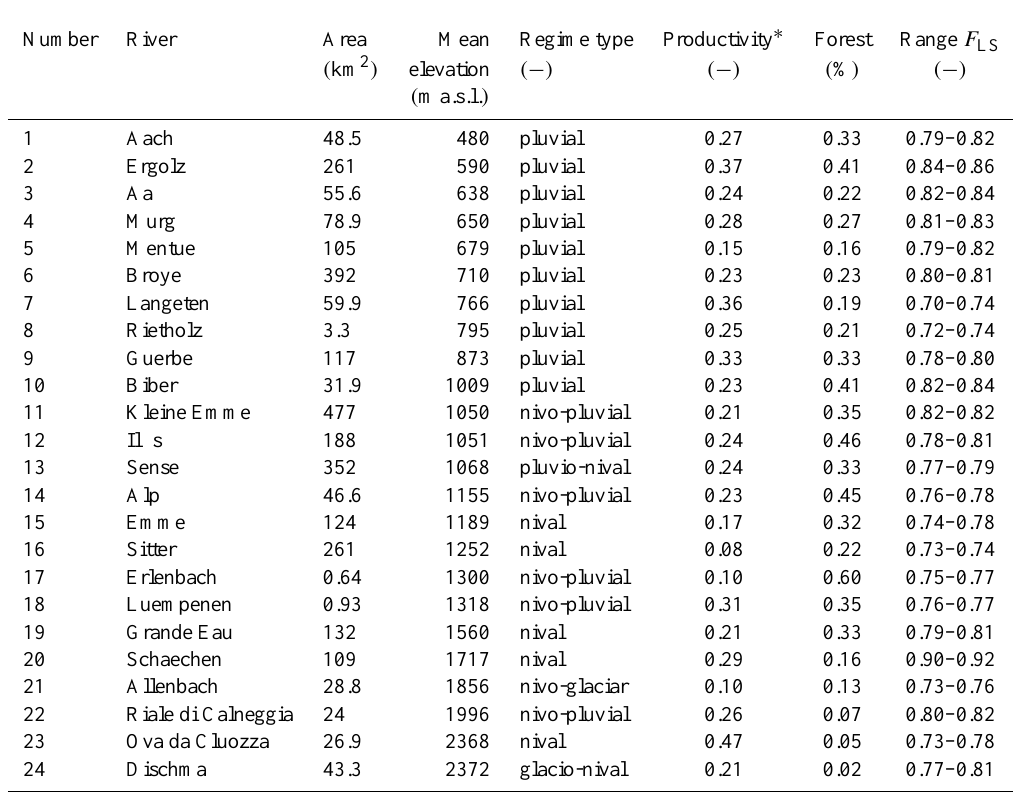
Table 1. Catchment characteristics (FOEN, 2013b) and calibration results; the catchments are sorted by mean catchment elevation. F LS is the model efficiency (Eq.